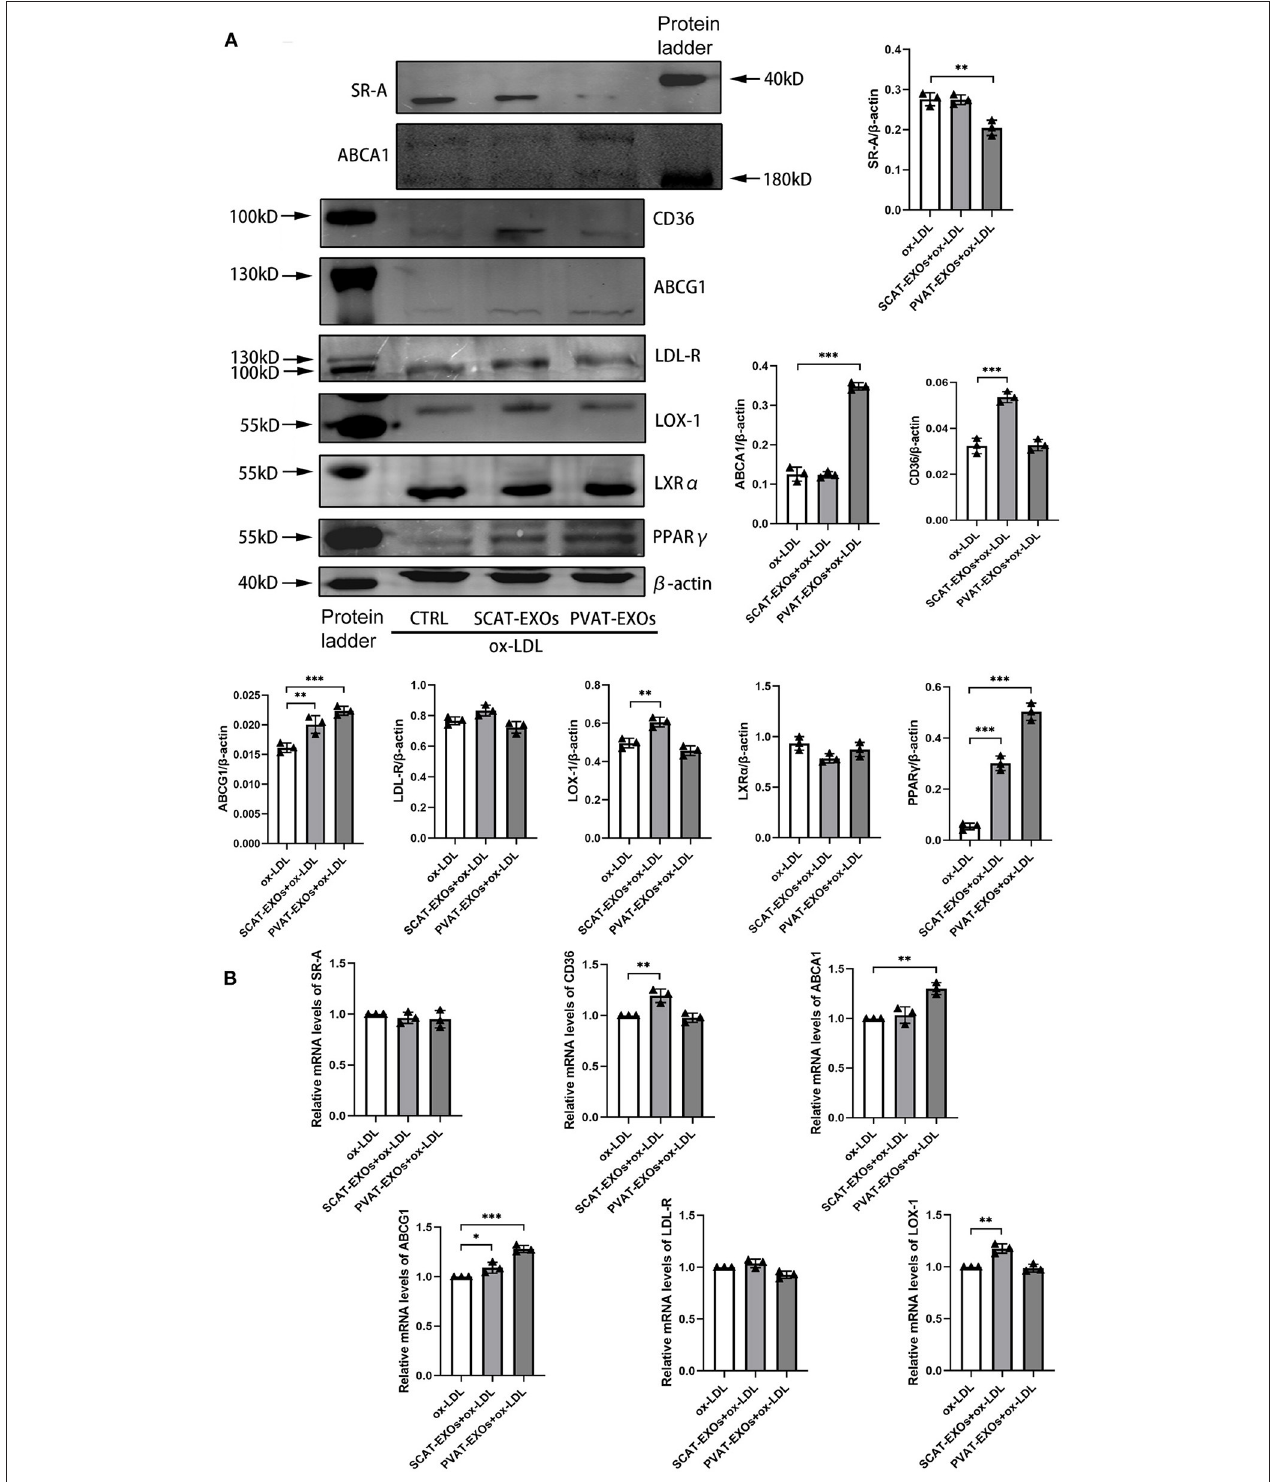
FIGURE 6 | The expression of cholesterol transporters in macrophages was regulated by SCAT-EXOs and PVAT-EXOs. RAW264.7 cells were incubated with SCAT-EXOs, PVAT-EXOs or equal amounts of PBS and then incubated with ox-LDL. Western blot analysis showed the expression of the cholesterol transport proteins SR-A, CD36, LDL-R, LOX-1, ABCA1, and ABCG1 and the upstream proteins LXR α and PPAR γ (A) . The expression levels were normalised to β -actin. The mRNA expression levels of SR-A, CD36, LDL-R, LOX-1, ABCA1 and ABCG1 were analysed by real-time PCR and normalised to GAPDH (B) . Ctrl: control group. * P < 0.05, ** P < 0.01, *** P < 0.001 vs. the ox-LDL group.